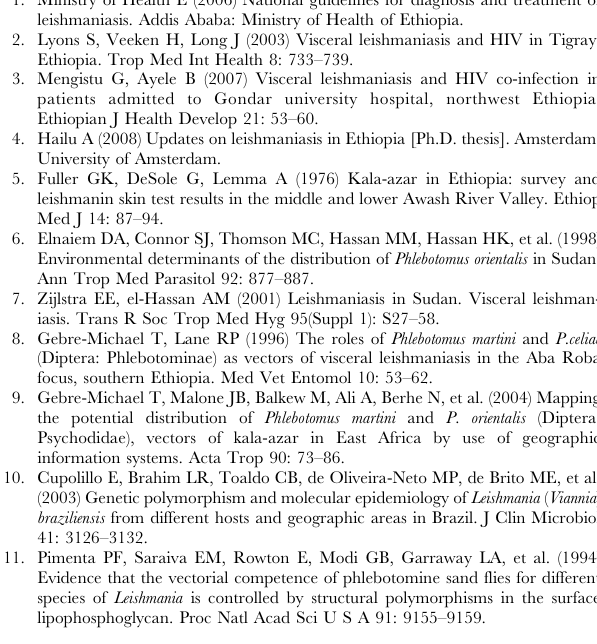
Table S4 Comparison of FIS values between populations, sub- populations and clusters defined by geographical origin and year of isolation for Ethiopian strains of L. donovani alone (n= 63), and populations, subpopulations and clusters identified for all L. donovani strains from East Africa analysed in this study (n= 95).